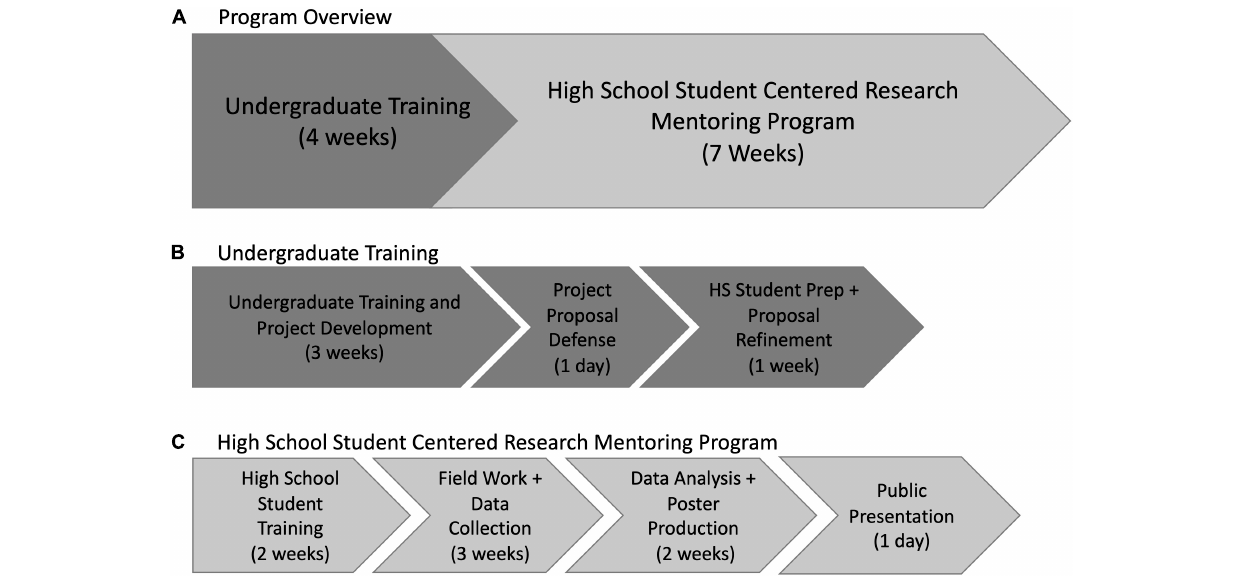
FIGURE 1 | Project TRUE (Teens Researching Urban Ecology) 11-week programmatic model. (A) Mentors worked Monday–Friday for approximately 35 h per week for the duration of the program. During the first 4-week block (B) , mentors met with program staff 3–4 days per week for training (https://bronxzoo.com/learn/youth/mentoring) and spent 1–2 days per week independently developing their research project. For the remaining 7 weeks of the program (C) , high school students attended Project TRUE 3 days per week for approximately 18 h of weekly contact time. On days when high school students were not present, mentors meet with informal educators, graduate students, and faculty PIs to continually reflect on and review progress, discuss ongoing challenges, technical aspects of research, and prep for HS student